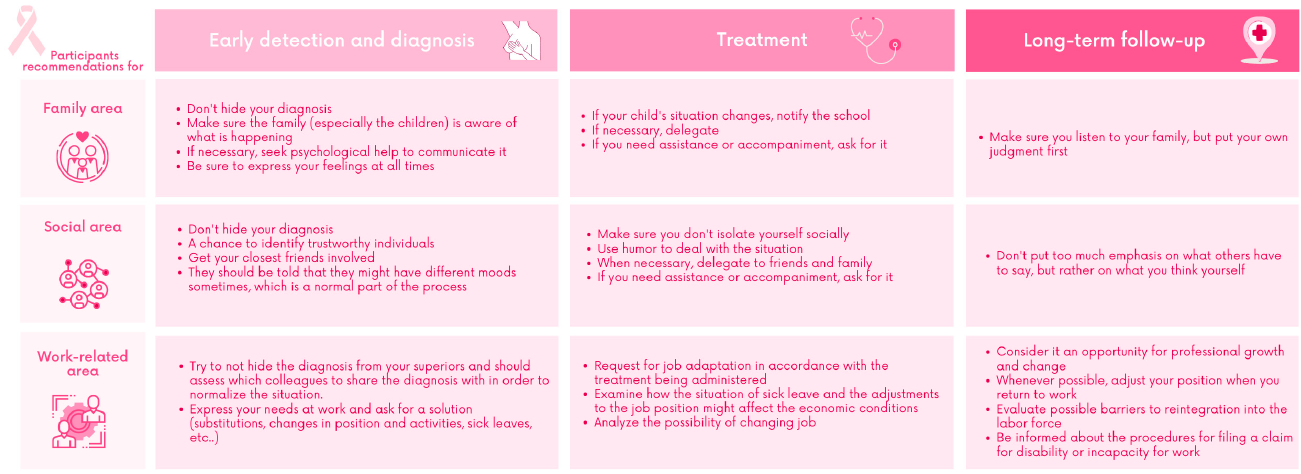
Figure 2. Participant recommendations for other patients.